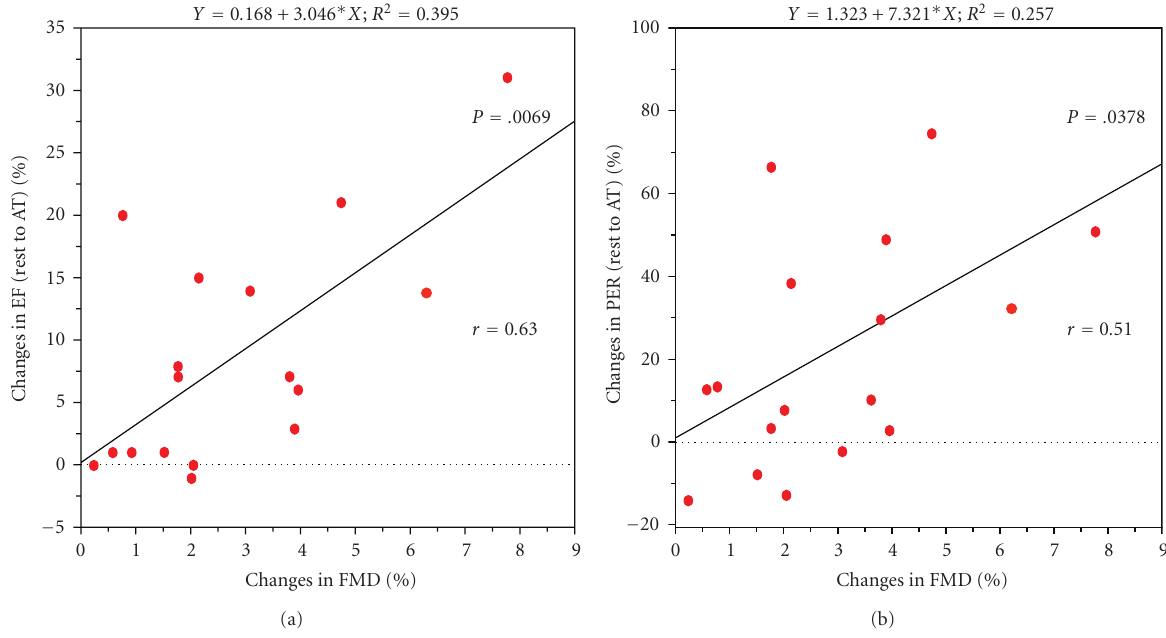
Figure 3: The correlation between flow-mediated vasodilation and cardiac response to exercise in the patients not on ACE-inhibitors. FMD: flow-mediated vasodilation; EF: left ventricular ejection fraction; PER: peak ejection rate.